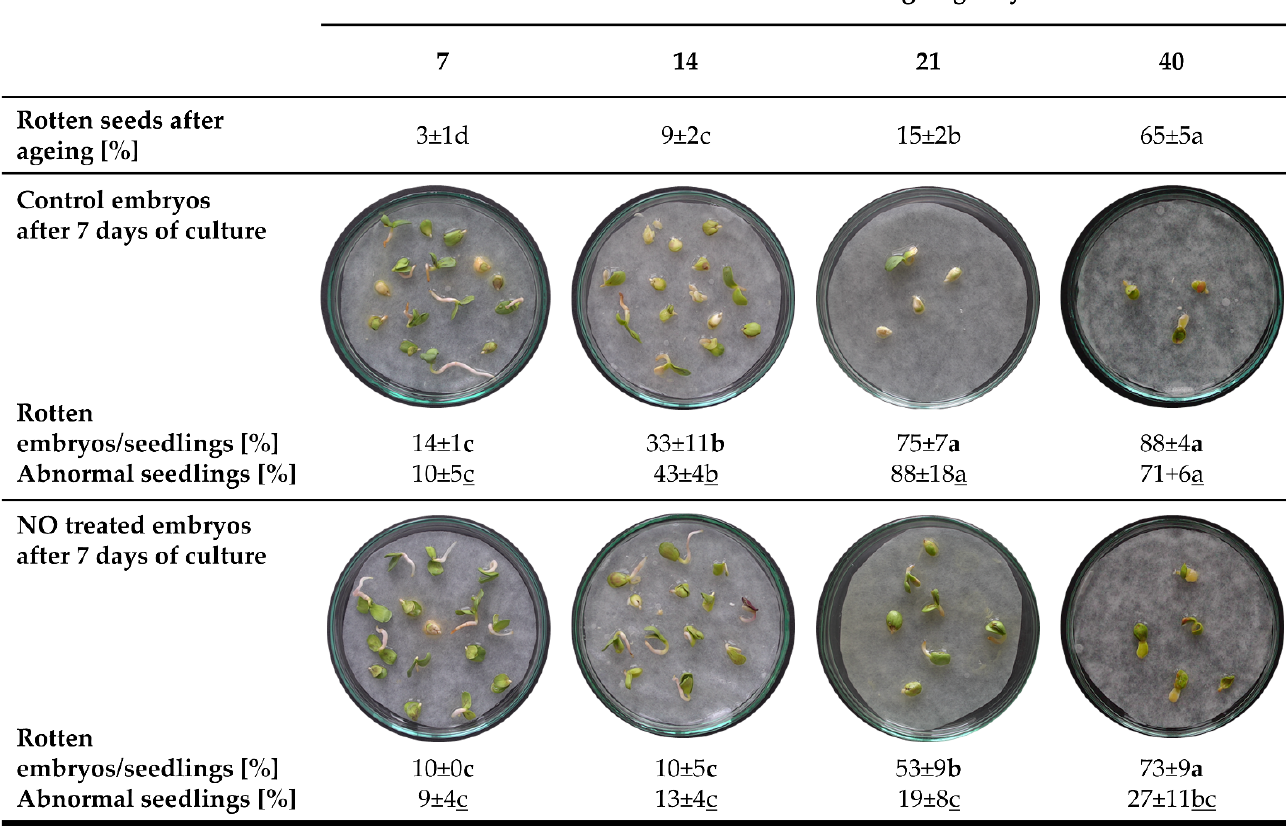
Figure 2. The number of rotten seeds determined after 7, 14, 21 or 40 days of accelerated ageing and the degenerative and morphological changes of embryos/seedlings after 7 days of the culture of embryos isolated from aged seeds (control) or embryos isolated from aged seeds and treated with NO. Values are the average of three independent experiments with 90 embryos in each (45 control and 45 NO treated). Homogenous groups were evaluated using Tukey’s test and signed as a–d (rotten seeds), a – c (rotten embryos/seedlings) and a–c (abnormal seedlings).